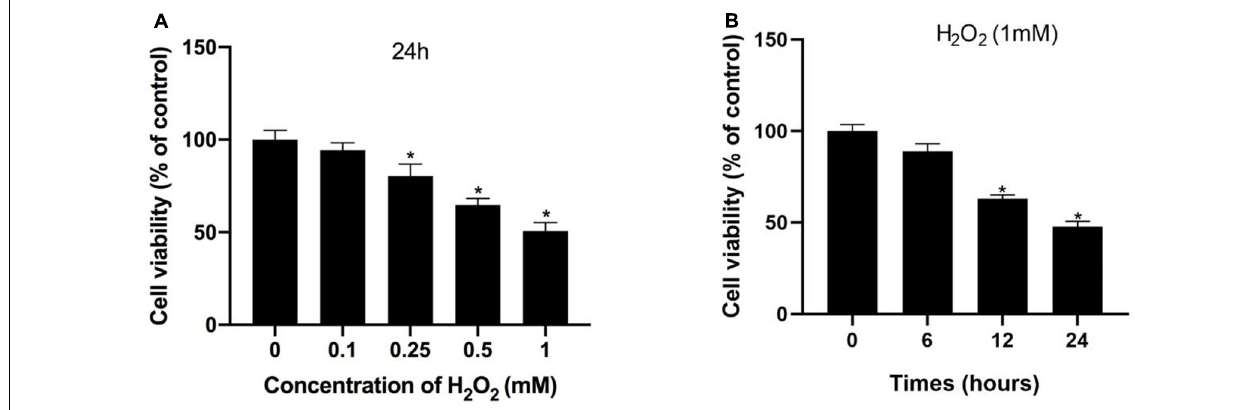
FIGURE 1 | Hydrogen peroxide inhibited cell viability in NP cells. (A,B) Effects of H 2 O 2 on cell viability were detected using the Cell Counting Kit-8 (CCK-8). * p < 0.05 vs. control group.